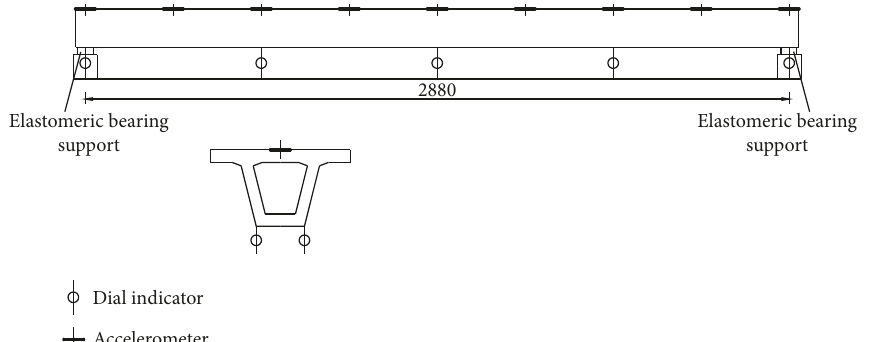
Figure 6: Layout of measurement points (unit: cm).